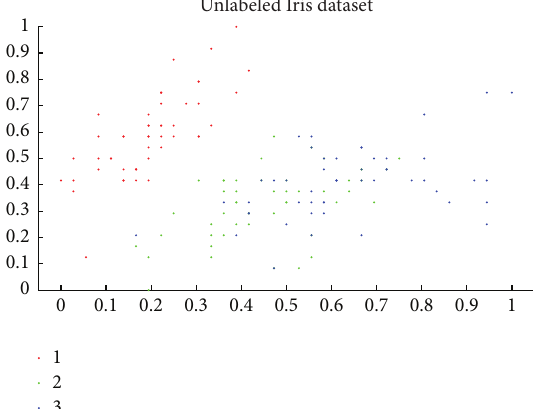
Figure 7: Two-dimensional projection of Iris dataset onto first two principal